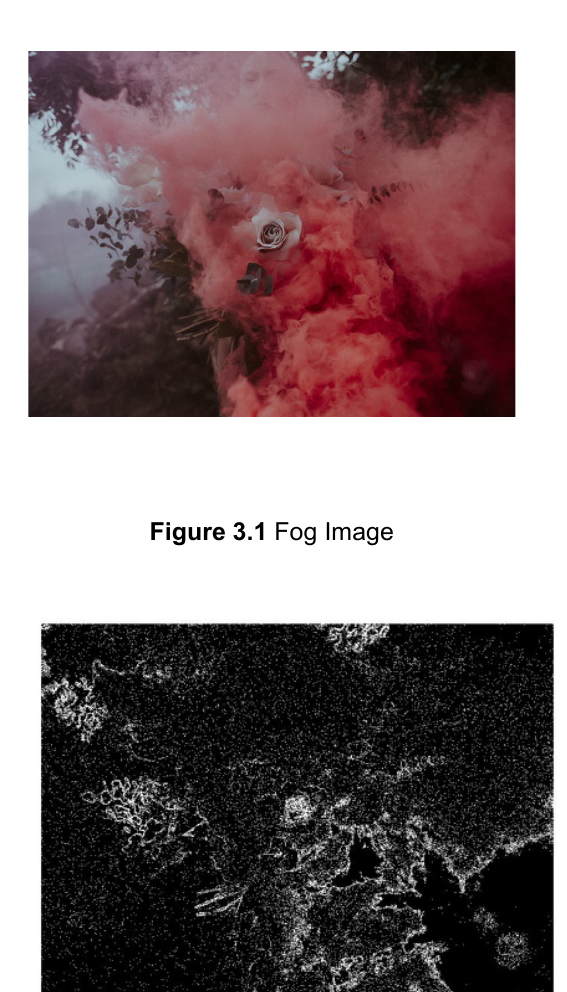
Figure 2.1 Plant Image